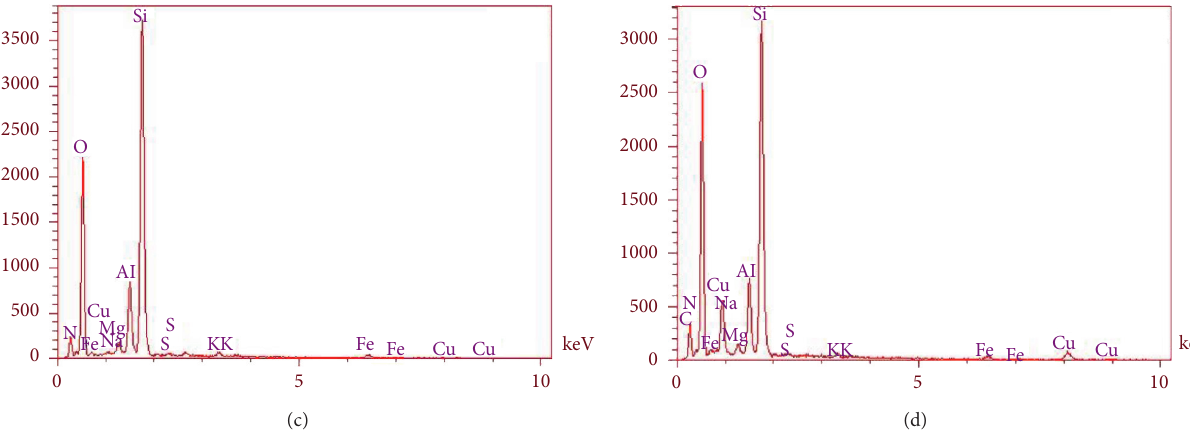
Figure 4: EDX spectrum of MMT K10 (a), MMT-[(CH Cu(II) (d).